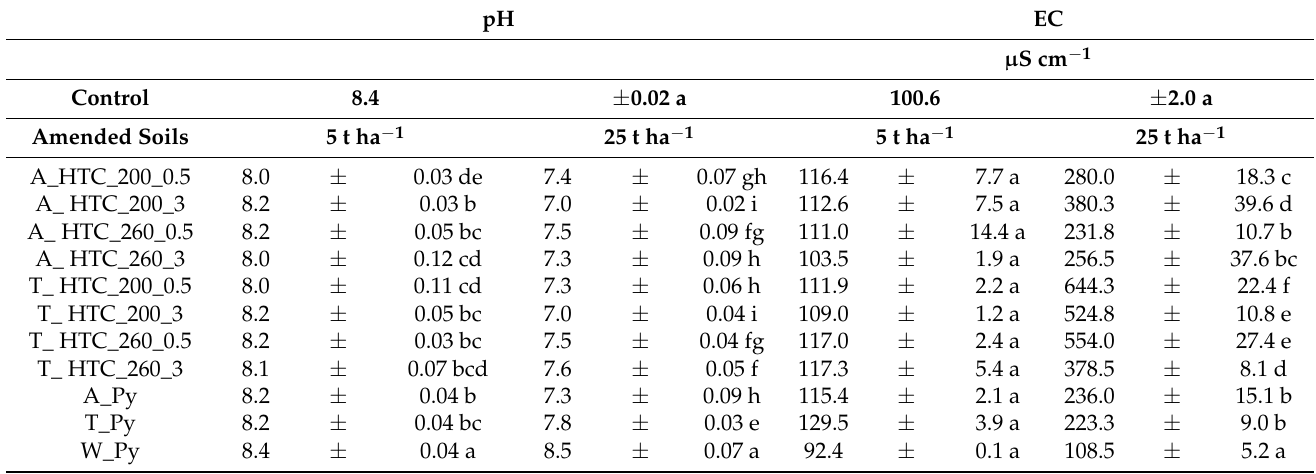
Table 2. Soil pH and electrical conductivity (EC) in the control (soil without amendment) and hydrochar- and pyrochar- amended pots at 5 and 25 t ha − 1 at the end of the greenhouse experiment. The hydrochars were produced from primary (A) and secondary sludge (T) at 200 ◦ C and 260 ◦ C for 0.5 h and 3 h (A_HTC 200_0.5/3, A_HTC 260_0.5/3; S_HTC 200_0.5/3, T_HTC 260_0.5/3). The pyrochars A_Py and T_Py were obtained from primary and secondary sludge and W_Py from green waste. The values are the means ± standard deviations from four replicates. For all pH and EC values, the numbers followed by the same letter indicate no significant differences at the p < 0.05